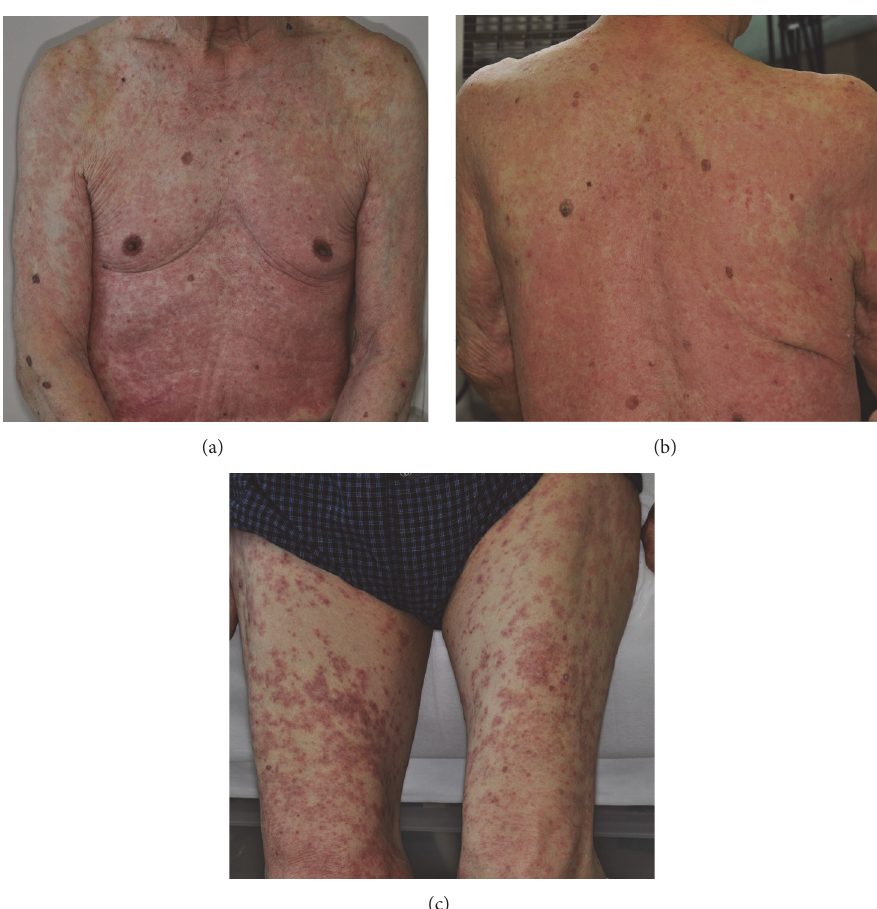
Figure 1: Clinical picture of the patient. Maculopapular rash on the trunk (a, b) and the thighs (c).